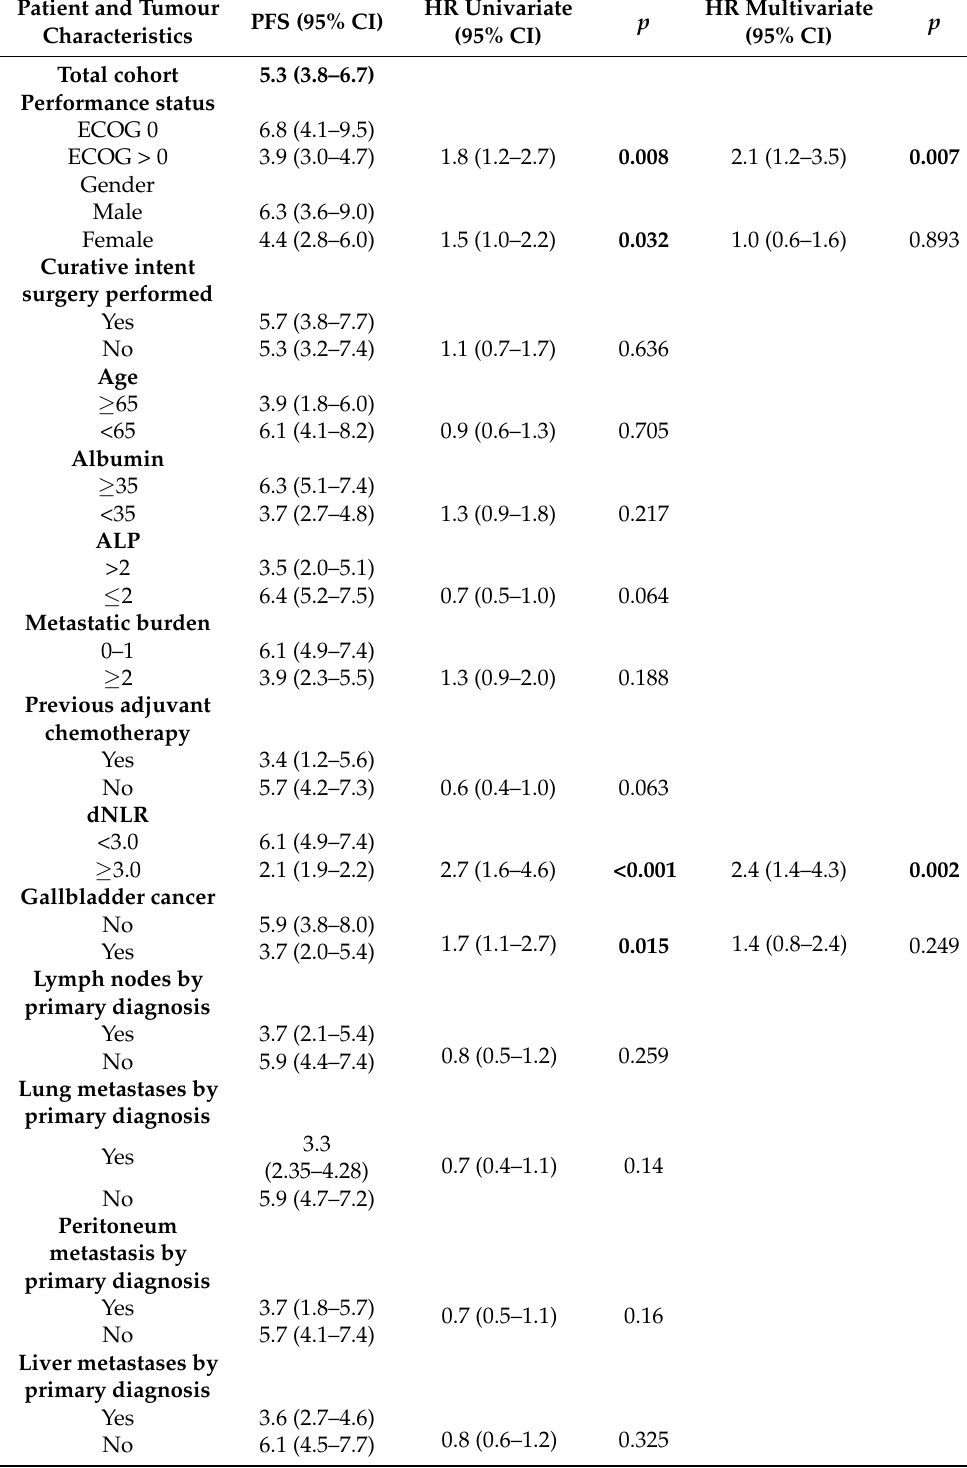
Table 4. Table showing median progression-free survival for different factors with univariate and multivariate